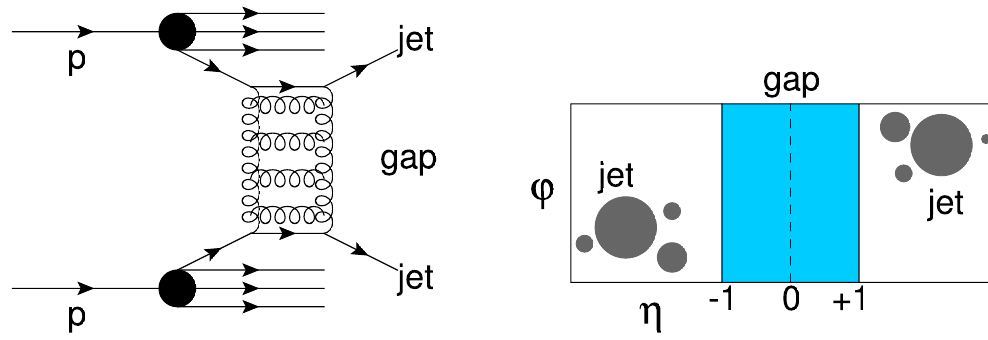
Figure 1 . Left: schematic diagram of the production of two jets separated by a large rapidity gap in a hadron-hadron collision via color-singlet exchange between quarks and gluons. Right: signature of jet-gap-jet events in the (pseudo-)rapidity-azimuthal angle ( η - φ ) plane. The blue shaded area represents the interval in pseudorapidity void of particles. Both diagrams are extracted from ref.